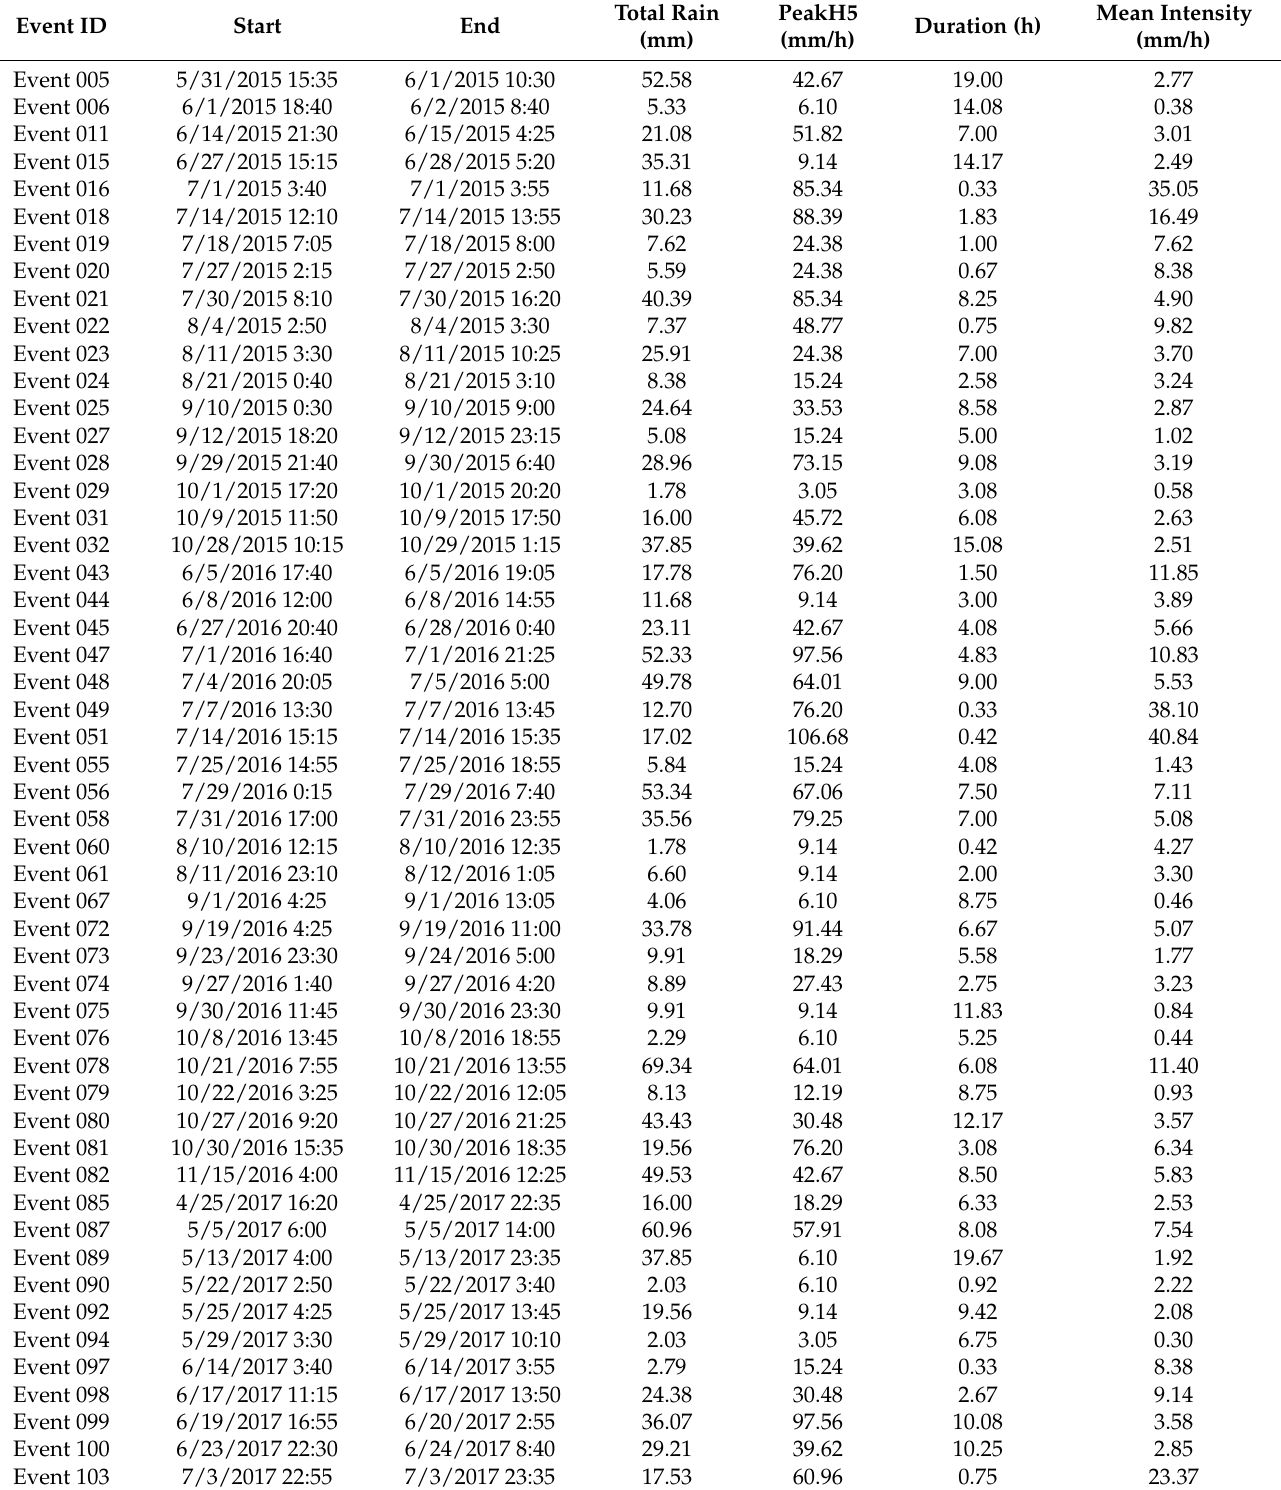
Table A1. Precipitation events at Happyland